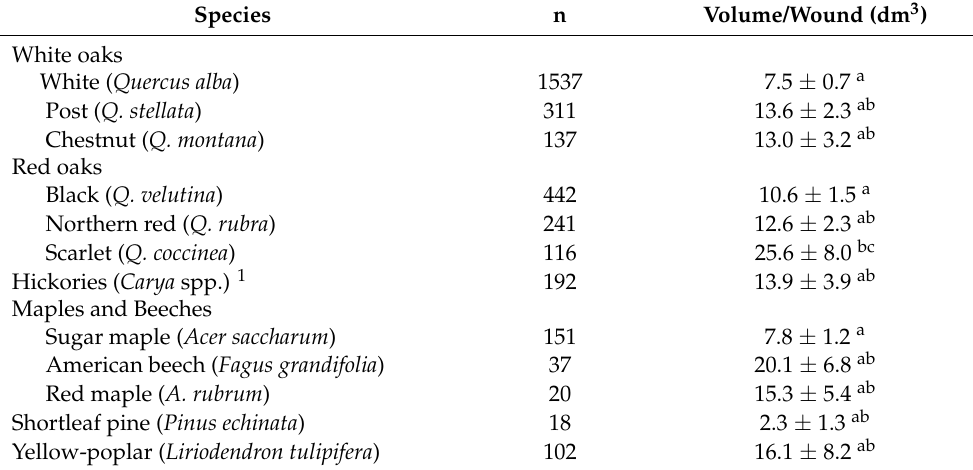
Table 4. Number of wounds observed (n) and mean volume ( ± standard error) loss per measured wound for common species observed in the study. Wound types with significantly different volume sizes (Tukey’s HSD test, α = 0.05) are denoted by different superscripted letters. Note that more than one wound or wound type could be observed on an individual tree. Latin names are given in